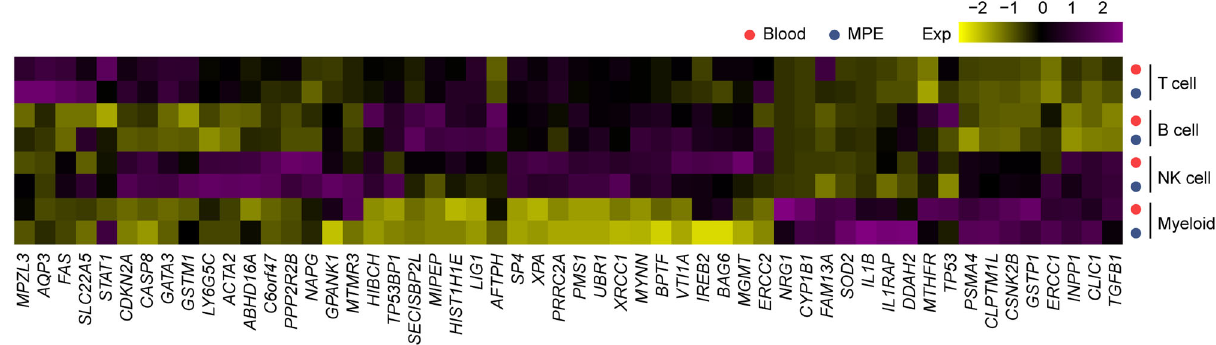
Fig. 6 The expression of genes determined by genome-wide association studies in MPE and blood. The heatmaps show the average expression levels of genes previously indicated in genome-wide association studies of non-small cell lung cancer in Chinese Han.